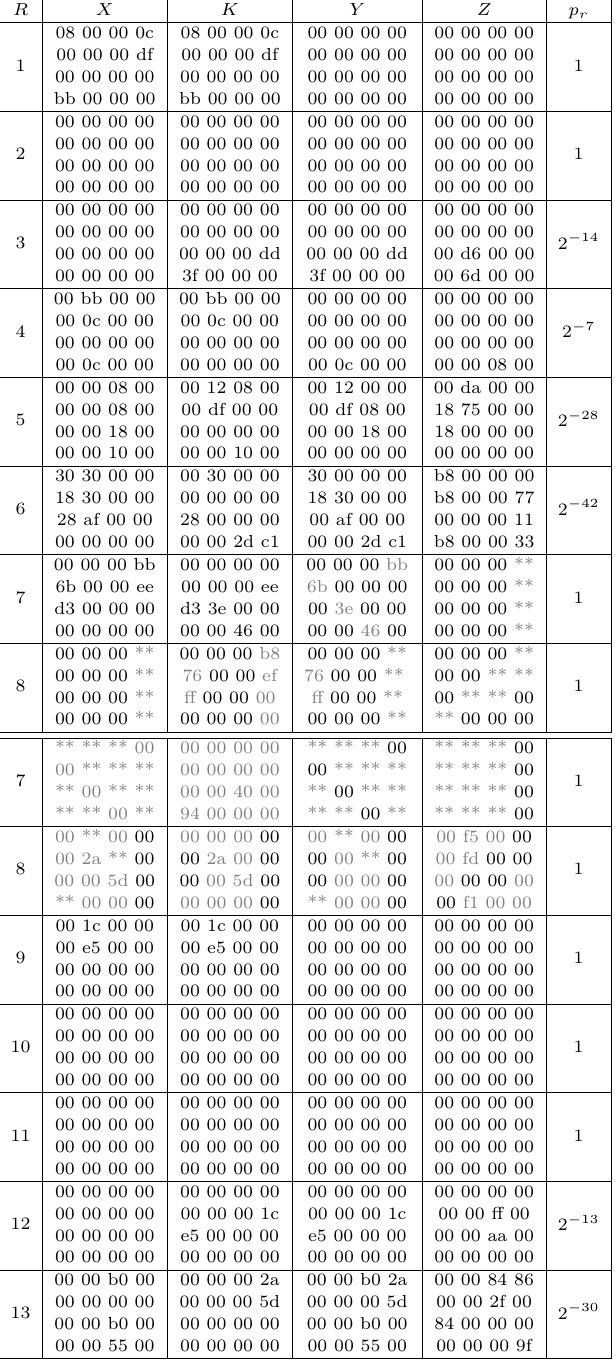
Table 14: 13-round distinguisher of